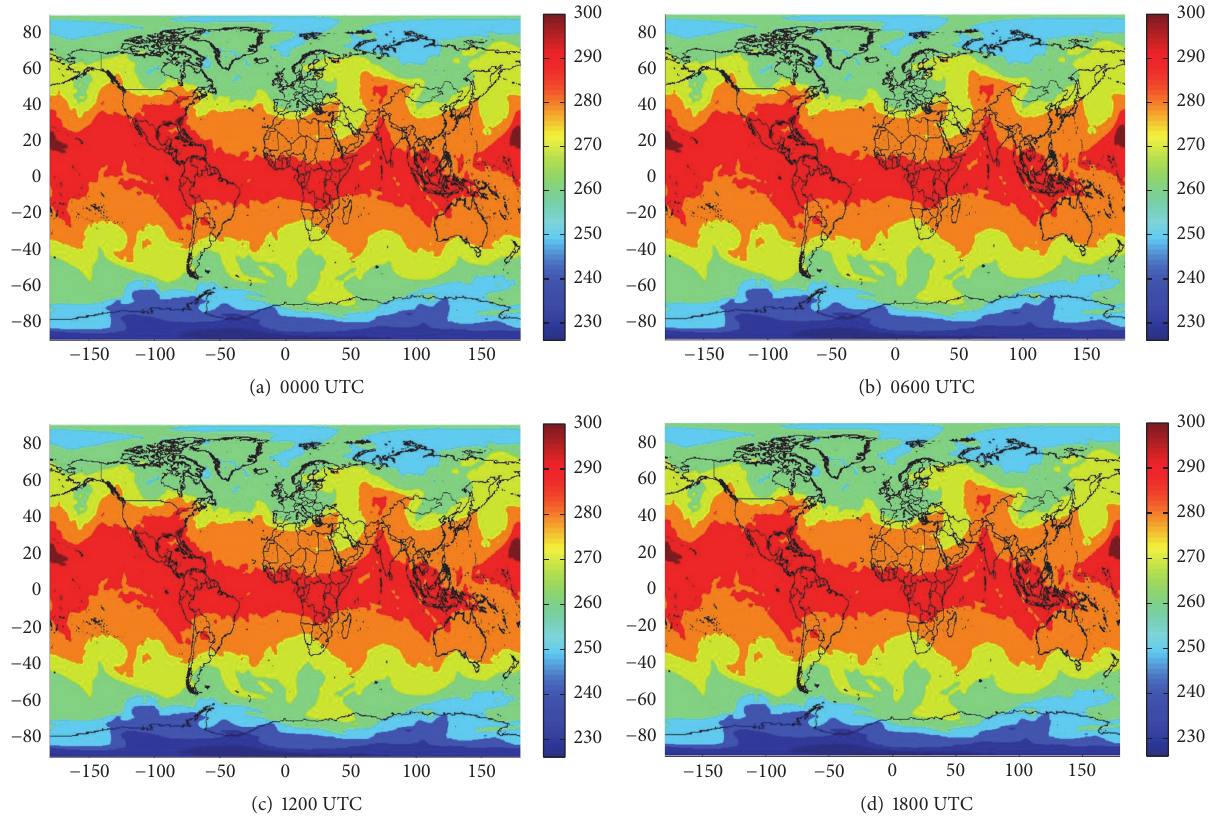
Figure 5: Data from CFSv2 of year 2010 (15/05/2010). Predictors: T850. Table 4: Experiment cases for AM, CAM, and